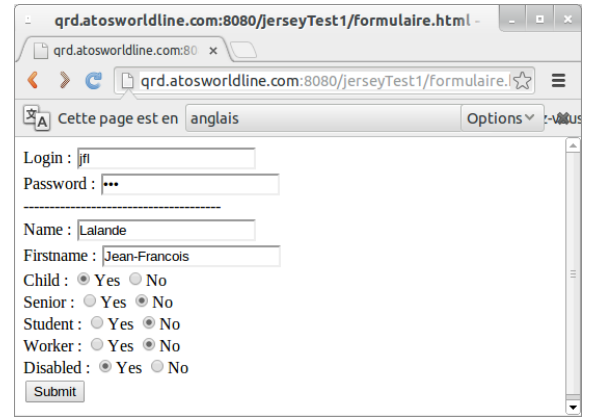
Figure 3. User account